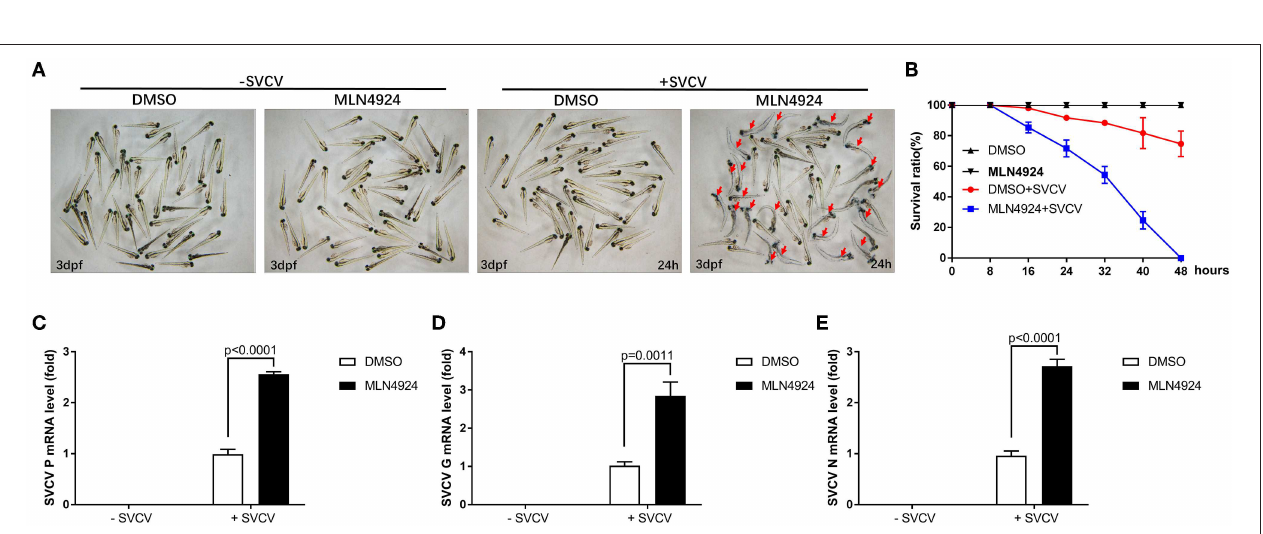
FIGURE 5 | Zebrafish larvae treated with MLN4924 are more sensitive to SVCV infection. (A) Representative images of zebrafish larvae (3 dpf), both uninfected and infected with SVCV for 24h, after treatment with the vehicle (DMSO; the control) or MLN4924 (1 µ M). Dead larvae (indicated with red arrows) were characterized by a lack of movement, absence of blood circulation, and bodily degeneration. (B) Survival ratios indicated that zebrafish larvae treated with MLN4924 were more sensitive to SVCV infection than were larvae treated with vehicle (DMSO). Zebrafish larvae (3 dpf; n = 90 in total) were infected with SVCV (2 × 10 8 TCID 50 /ml) after pretreatment with either vehicle (DMSO) or MLN4924 (1 µ M); this experiment was repeated three times ( n = 30 for each). We counted the numbers of dead larvae at 8, 16, 24, 32, 40, and 48h post-infection. (C–E) Viral replication was much greater in SVCV-infected zebrafish larvae treated with MLN4924 (1 µ M), as compared with the control. Zebrafish larvae were infected with SVCV after pretreatment with either vehicle (DMSO; the control) or MLN4924 (1 µ M). After incubation for 24h, we used qRT-PCR assays to determine the expression levels of the SVCV genes P (C) , G (D) , and N genes (E) . Data are shown as mean ± SEM of three independent experiments, each performed in triplicate; the statistical analysis was performed using GraphPad Prism 5 (unpaired t -test).